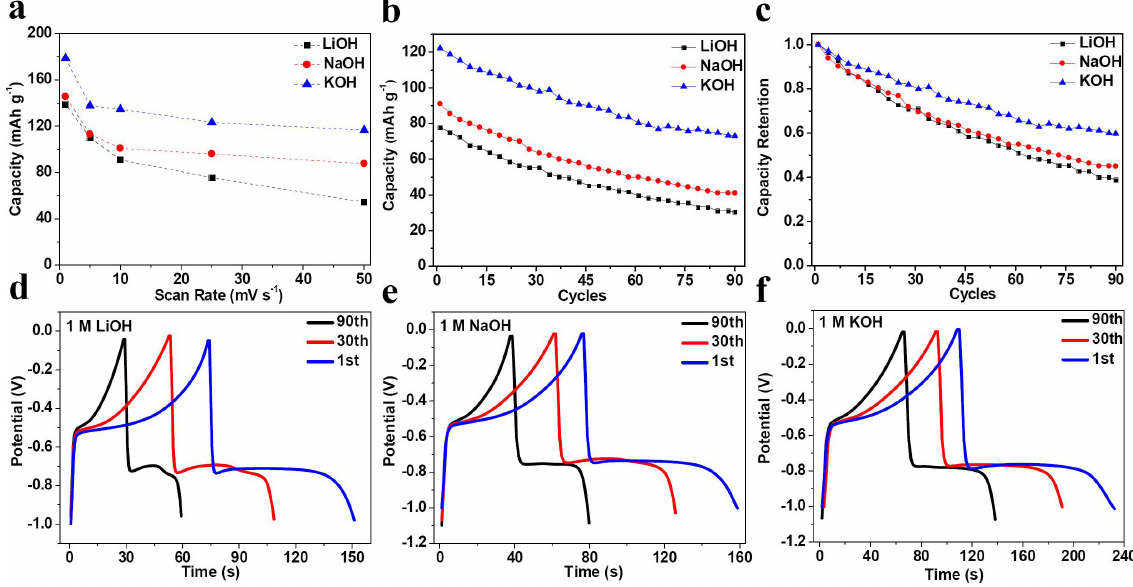
Figure 3. ( a ) Rate performance of Bi electrode at various scan rates; ( b ) Cycling performance and ( c ) Capacity retention of Bi electrode in 1 M LiOH, NaOH and KOH electrolytes at 2 A·g − 1 . Galvanostatic charge-discharge curves of the first, 30th and 90th cycle in ( d ) 1 M LiOH; ( e ) 1 M NaOH and ( f ) 1 M KOH